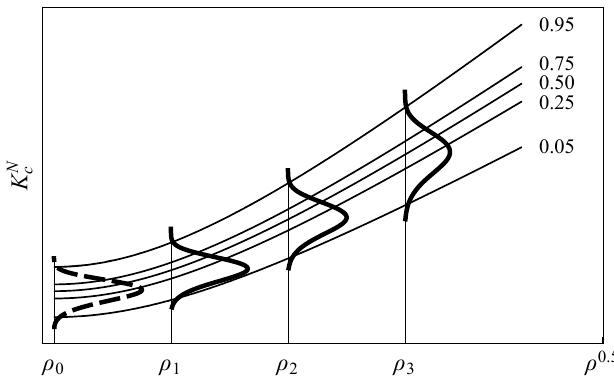
Figure 3. Schematic illustration of the probabilistic K N c − ρ 0.5 field for the proposed